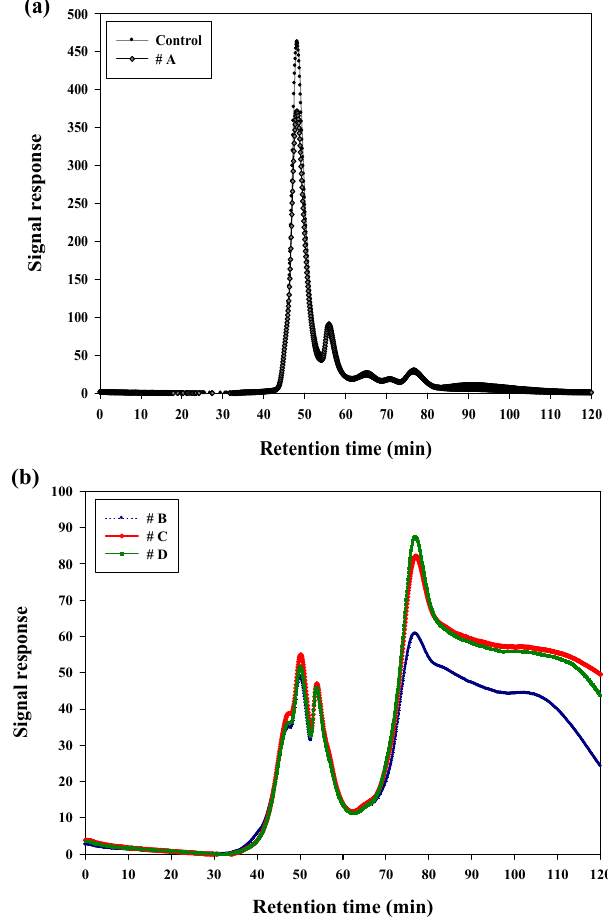
Figure 6. LC-OCD of cleaning water under each operating condition: ( a ) without coagulation and Condition A, ( b ) Conditions B, C, and D.